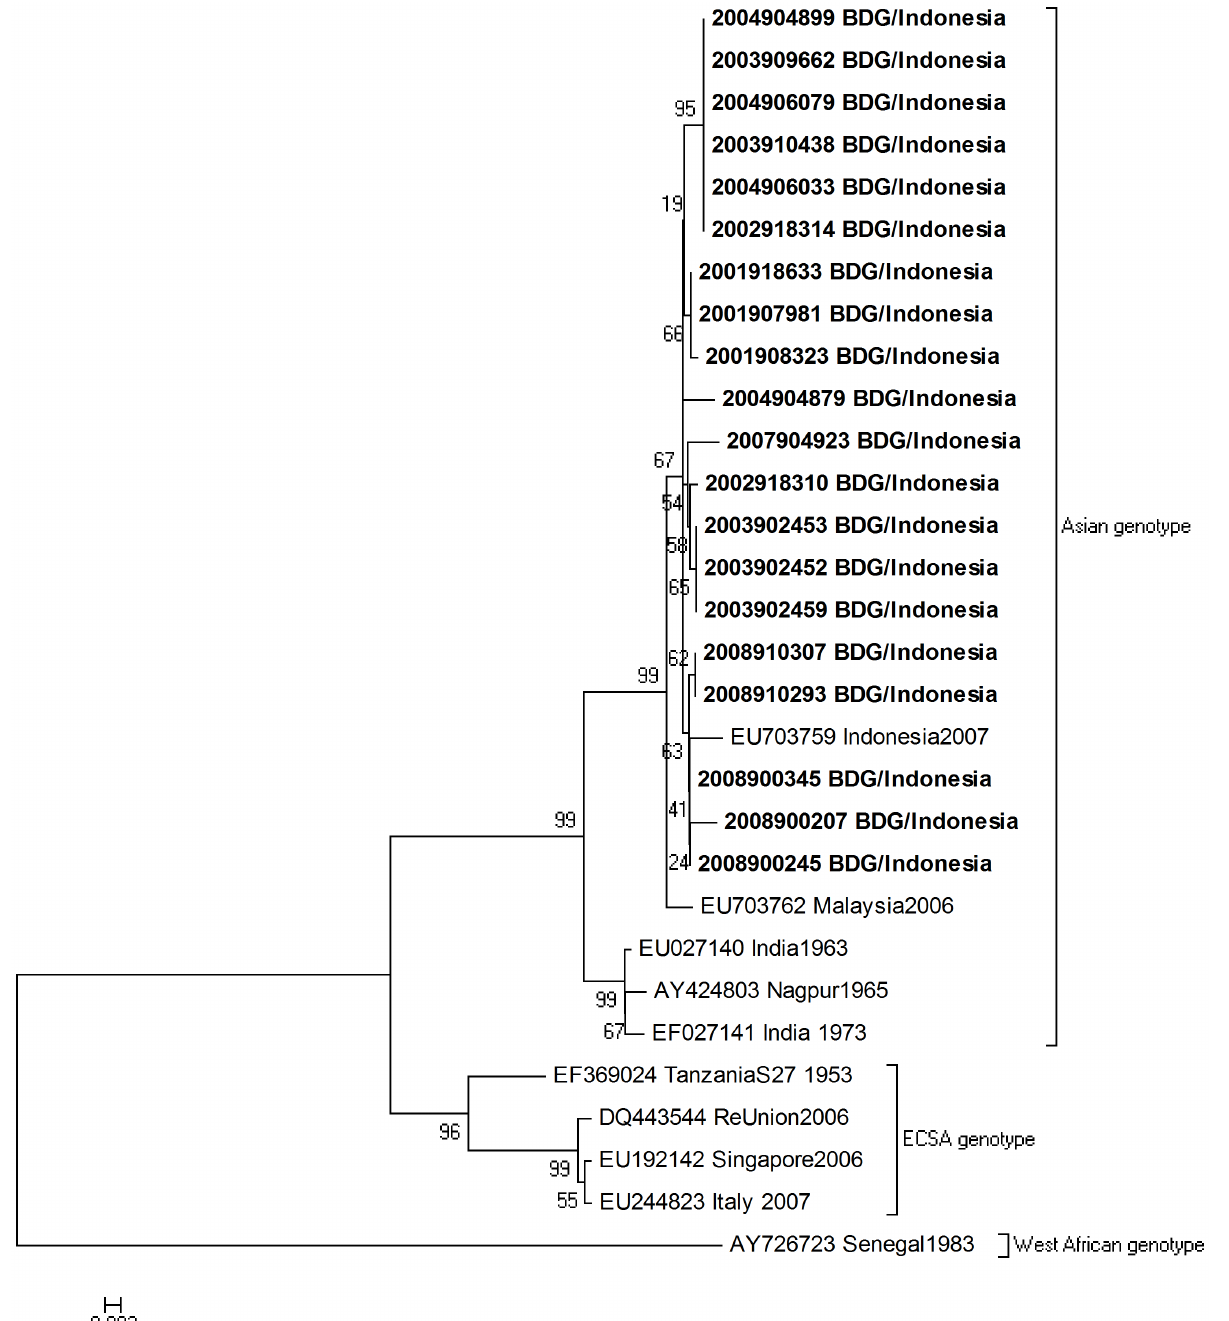
Figure 3. Phylogenetic analysis of the CHIKV isolates. Neighbor-joining tree of the structural polyprotein coding region of CHIKV. The sequences obtained in this study are highlighted in bold. Numbers indicate bootstrap values for the groups to the right.